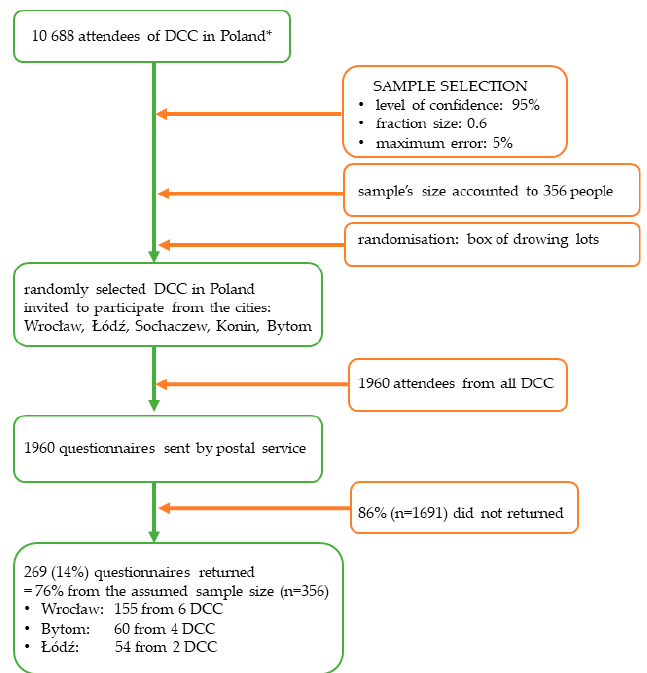
Figure 1. Recruitment of participants. Abbreviations: n , number of people; DCC , day care centres; % , percent. * based on the Report of the Supreme Chamber of Control in Poland, 2017 [20].